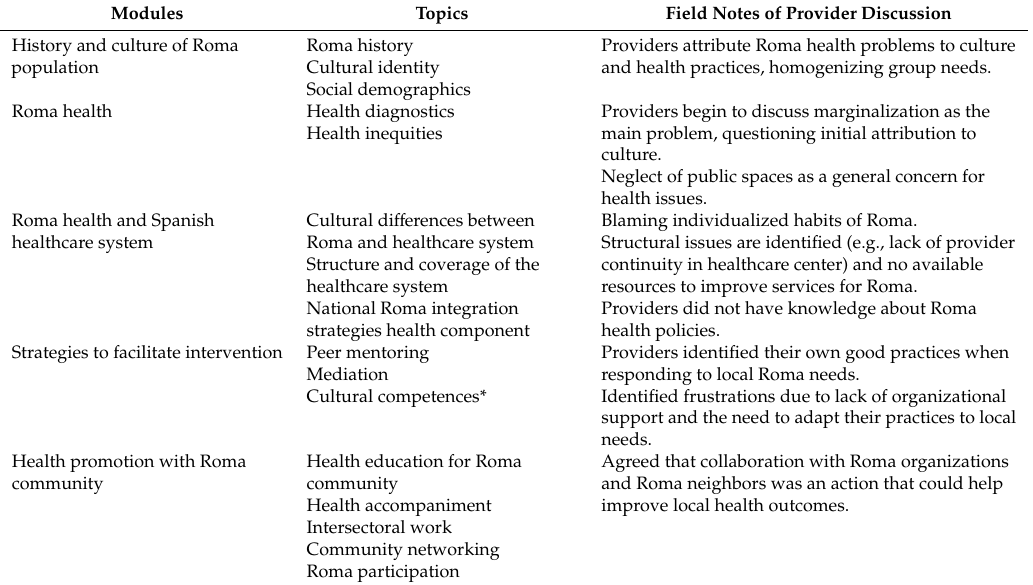
Table 2. Content of provider workshops with excerpts from research partner’s field